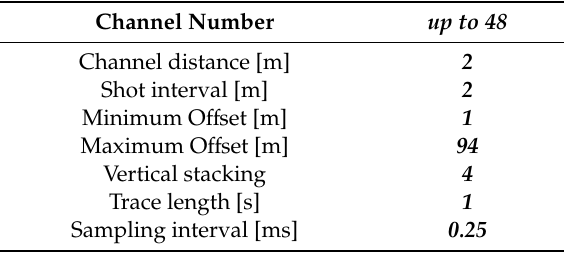
Table 1. Acquisition parameters of the reflection seismics’ profiles.